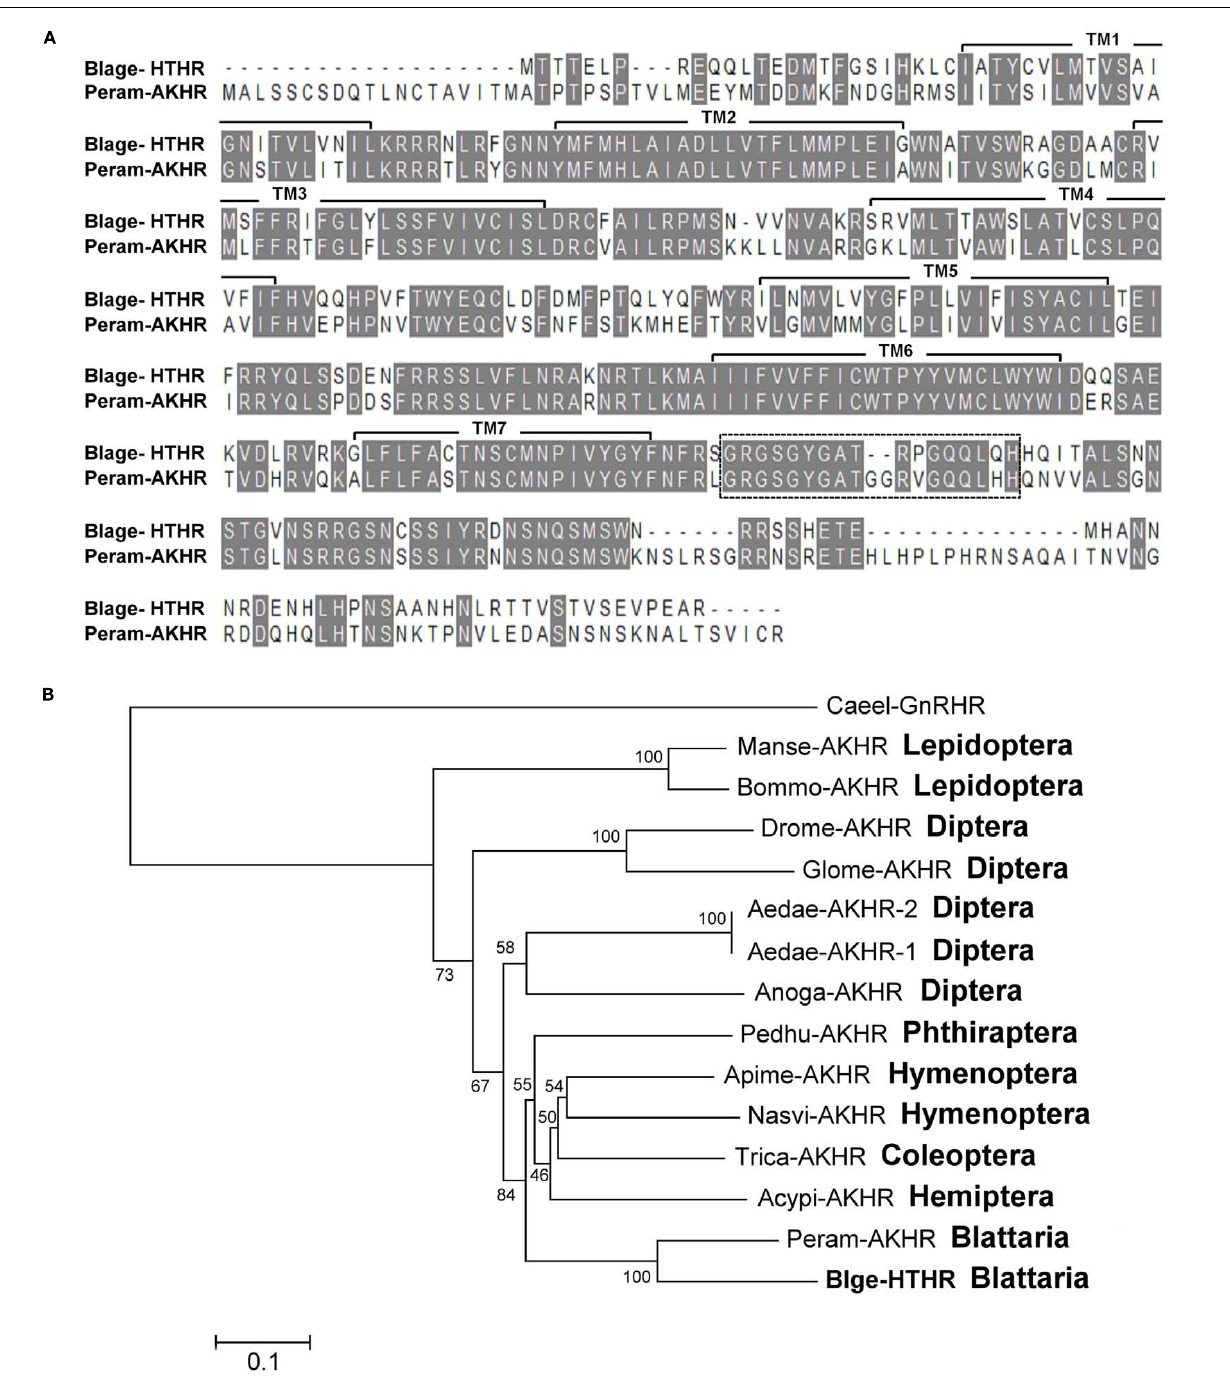
FIGURE 1 | (A) Alignment of the deduced amino acid sequences of the Blattella germanica HTH receptor (Blage-HTHR, GenBank GU591493) with the Periplaneta americana AKH receptor (Peram-AKHR, GenBank ABB20590). Identical amino acid residues are highlighted in gray.The seven transmembrane α -helices are indicated byTM1-7.The dotted-line rectangle indicates an insertion present in both cockroach species. (B) Neighbor joining tree of AKH receptor insect sequences.The tree was generated using MEGA 5 with 1000 bootstrap replicates.The evolutionary distance is given in units of the number of amino acid substitutions per site.The